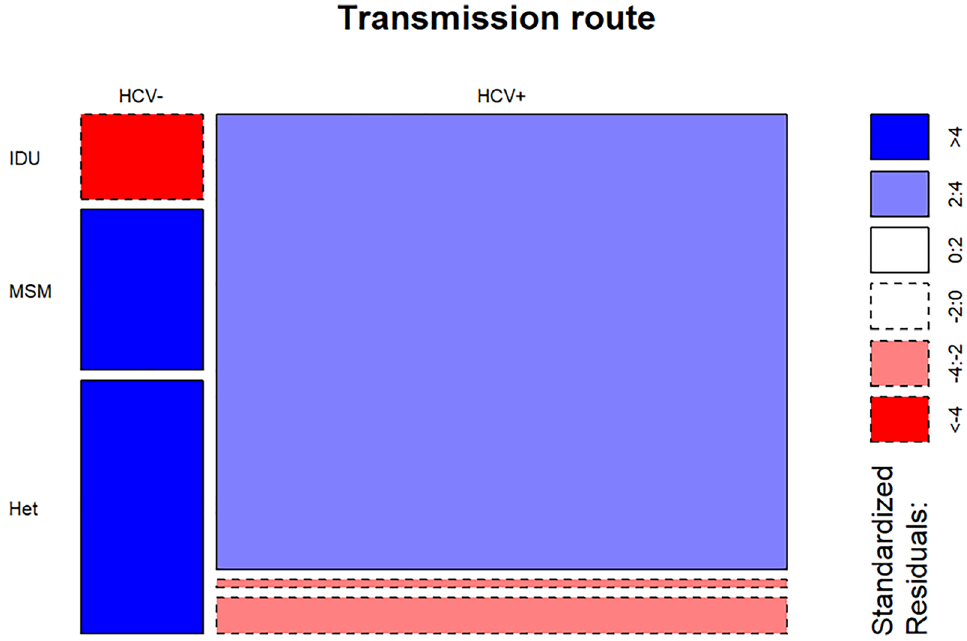
Figure 1. HCV coinfection by transmission route. The size of each rectangle is proportionate to the size of total number of individuals in that combination of HCV coinfection status and HIV transmission route. The color of each rectangle indicates how much that combination of variables differs from what would be expected if the two variables were unrelated. Blue indicates higher proportions than expected and red indicates lower proportions than